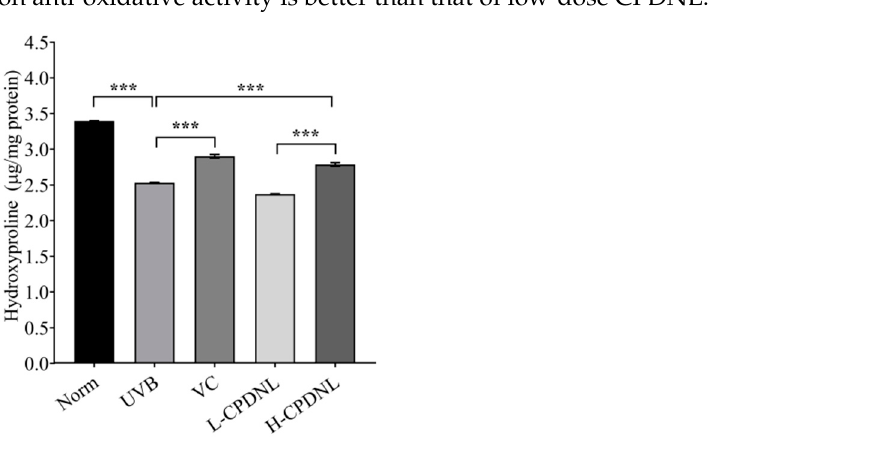
Figure 6. The hydroxyproline content ( μ g/mg protein) of skin tissue. Data represent means ± SEM. *** indicates p < 0.001.